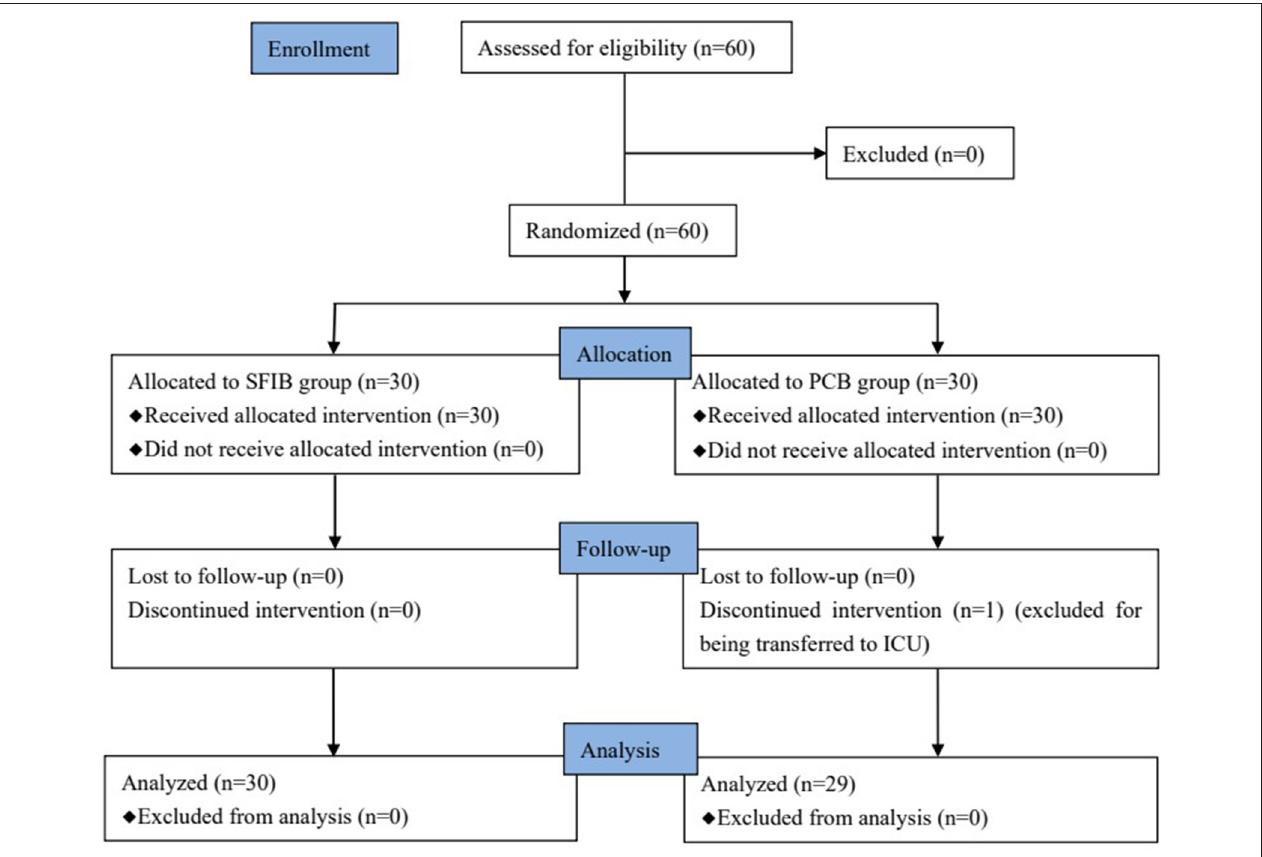
FIGURE 1 | Consort flow diagram for screening and enrollment. PCB, psoas compartment block; SFIB, supra-inguinal fascia iliac compartment block.